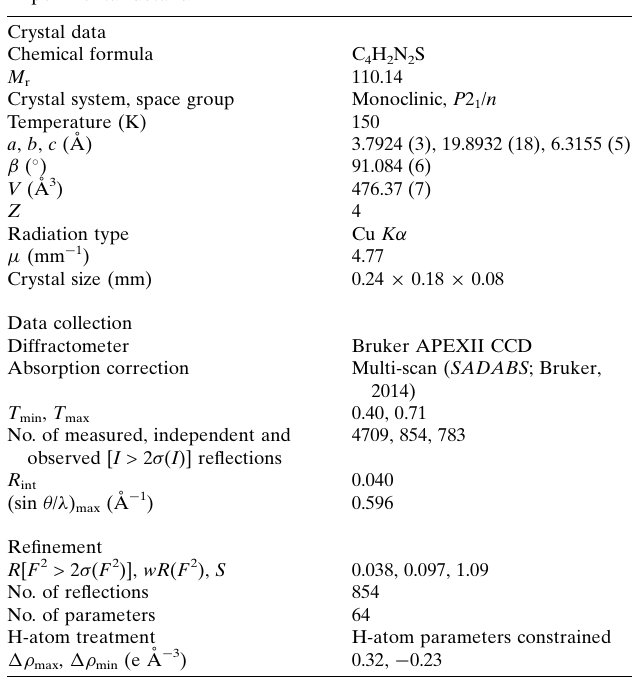
Table 2 Experimental details.